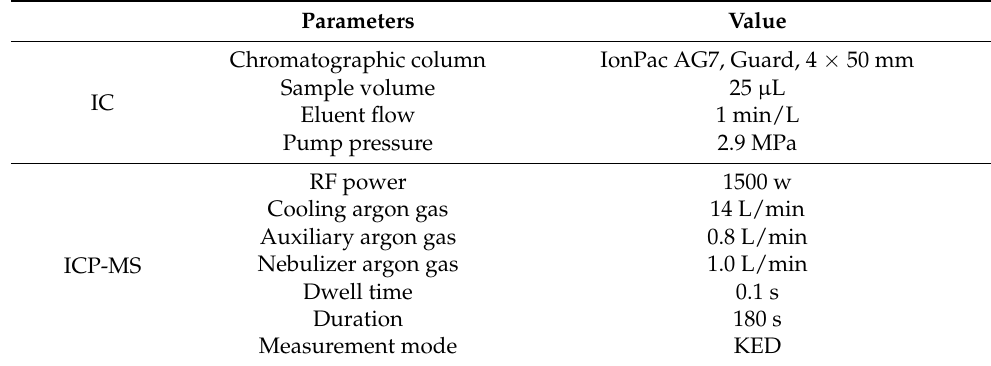
Table 3. Operating parameters for IC-ICP-MS.